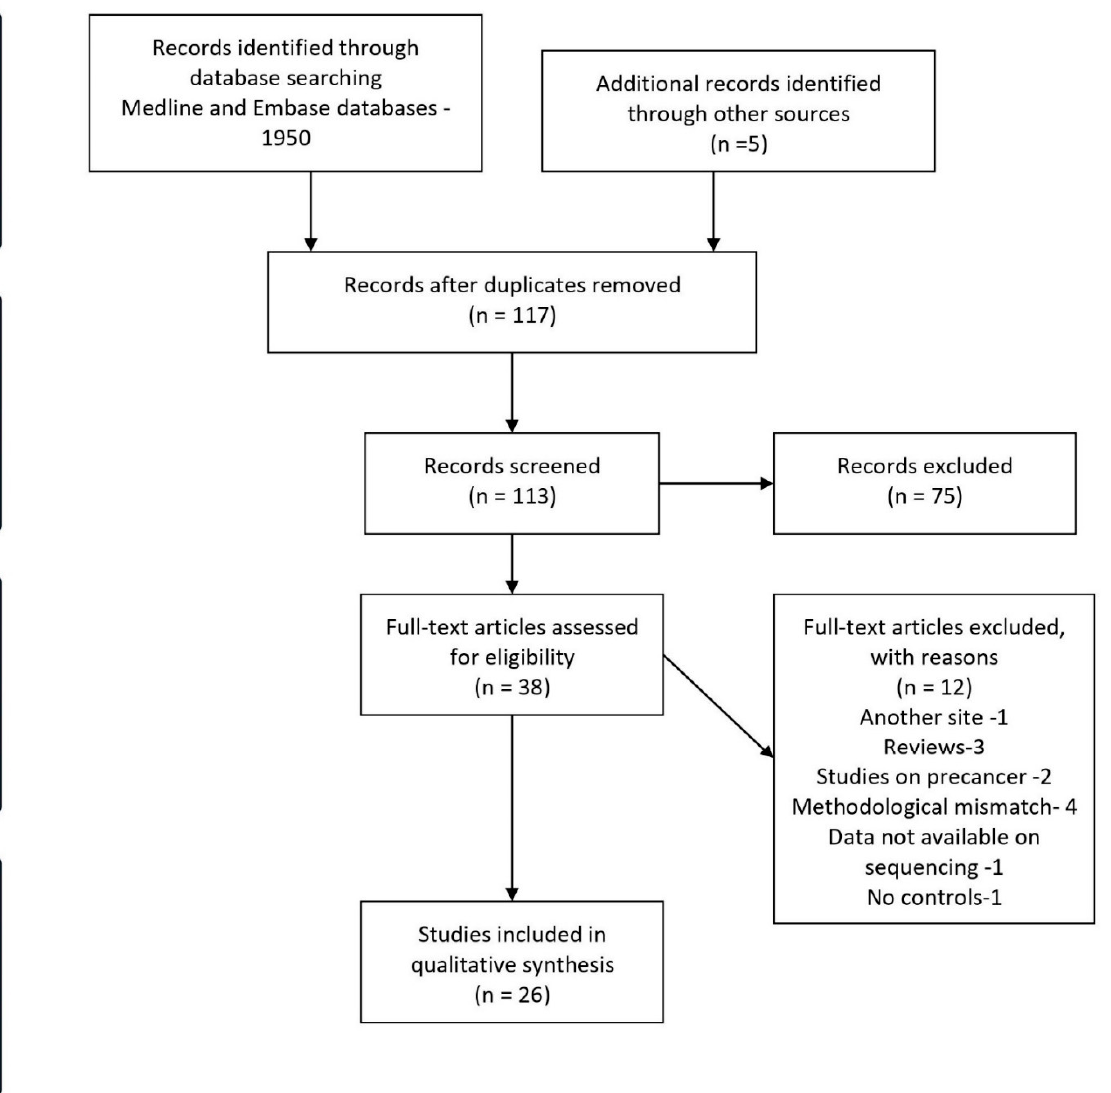
Figure 1. PRISMA flow chart for the selection of studies.